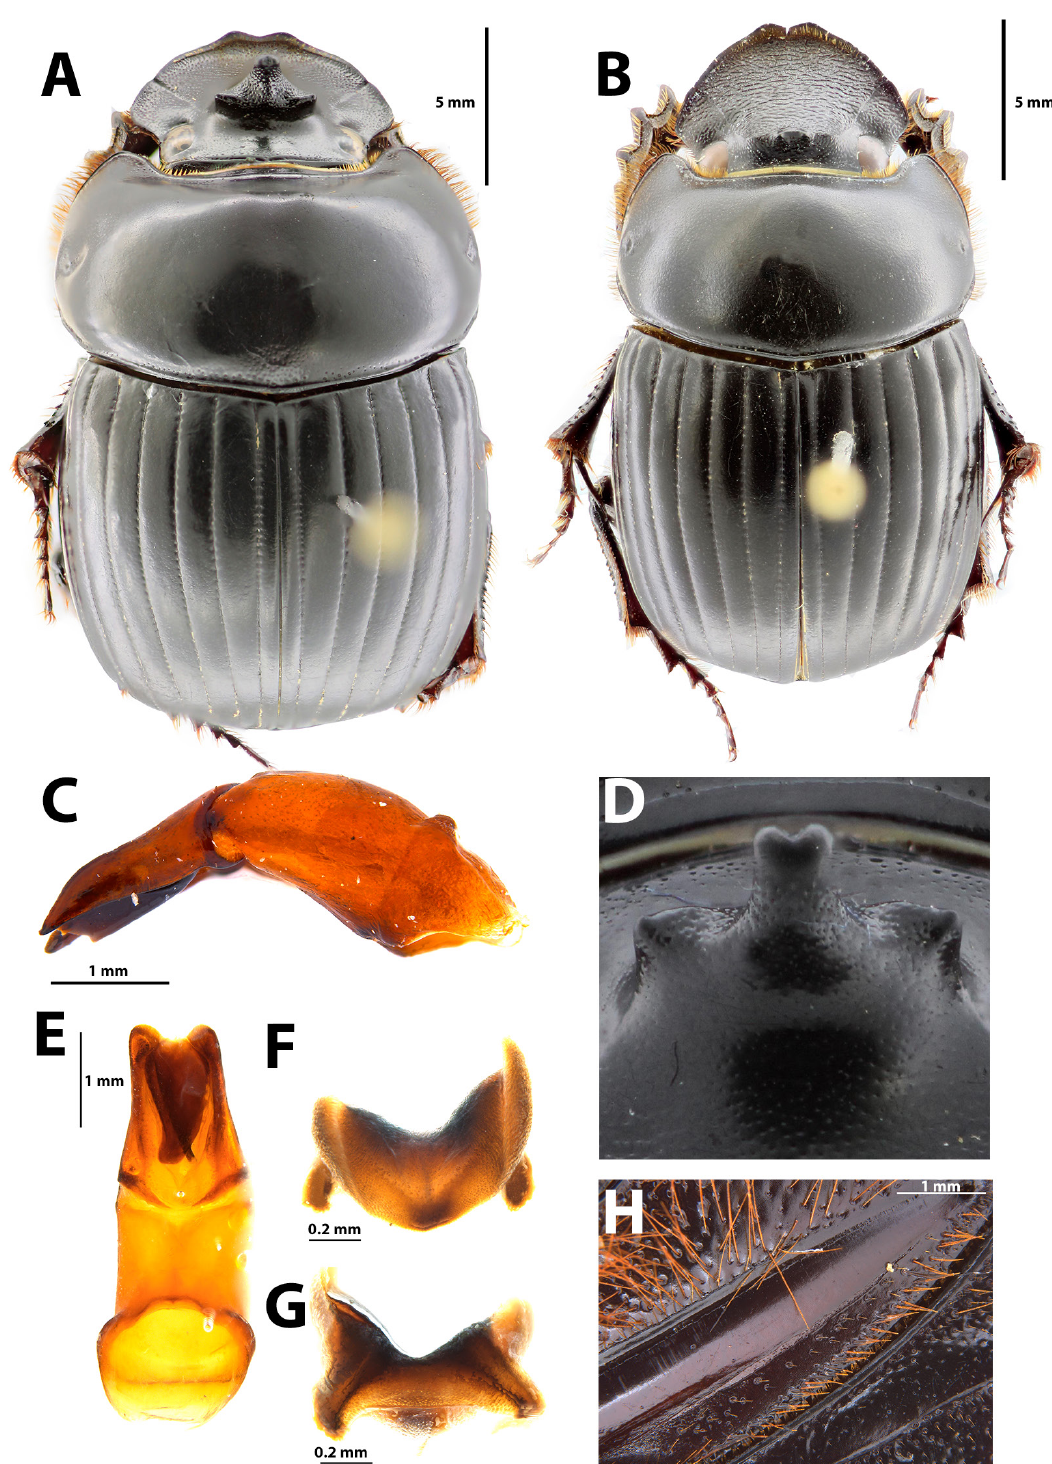
Fig. 4. Dichotomius amplicollis (Harold, 1869). A–B . Dorsal habitus. A . ♂. B . ♀. C . Lateral view of the aedeagus. D . Anterior view of the cephalic carina, the central tubercle cylindrical and apically emarginate. E . Ventral view of the aedeagus. F–G . Lamella copulatrix. H . Ventral view of the metacoxa, displaying a single row of organized ocellate setigerous punctures which merge together on the posterior